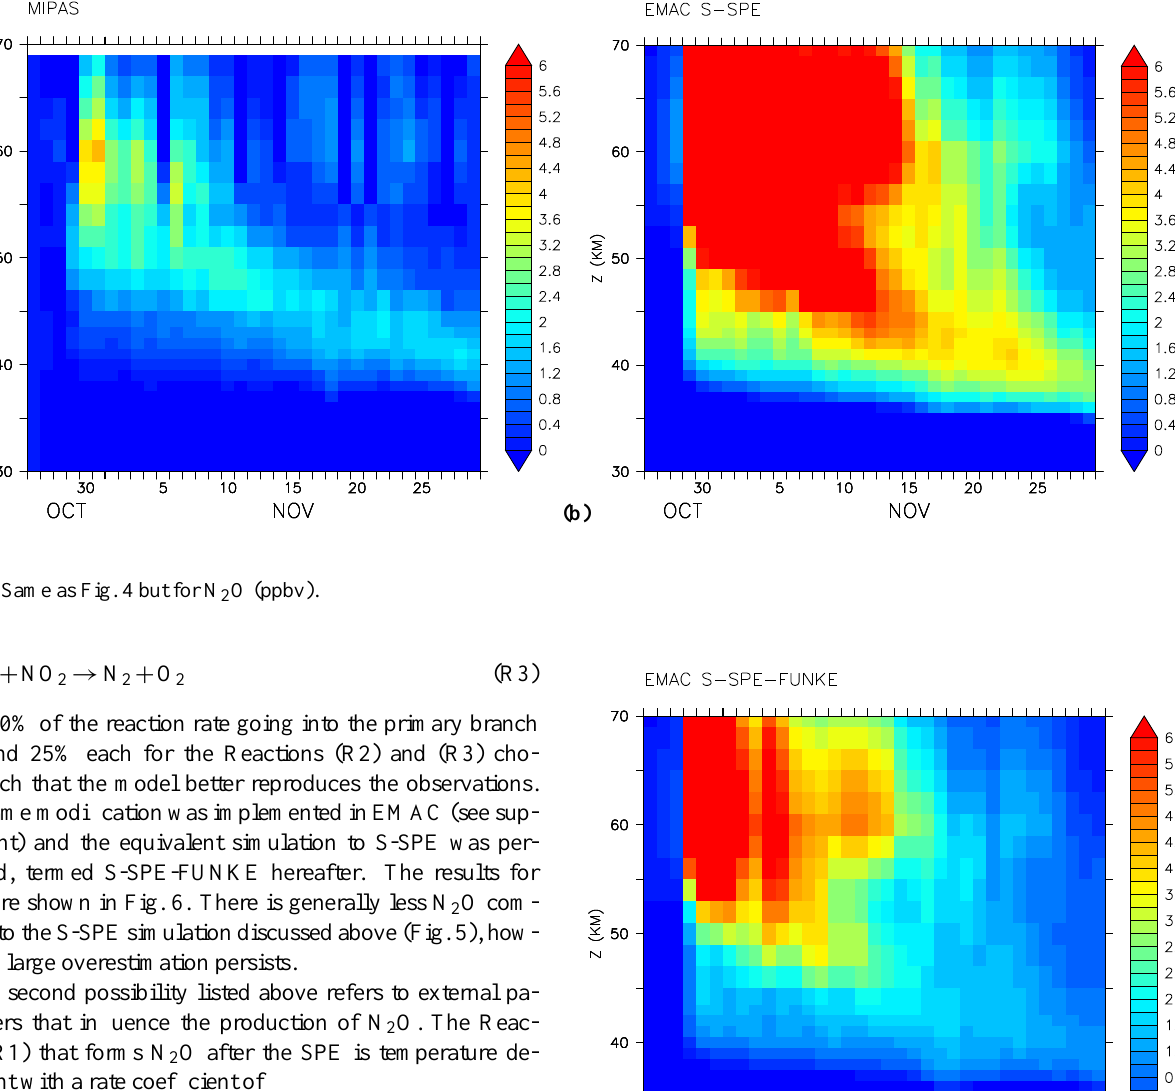
Fig. 6. N 2 O change (ppbv) in EMAC simulation S-SPE-FUNKE with respect to 26 October for 70–90 ◦ N.